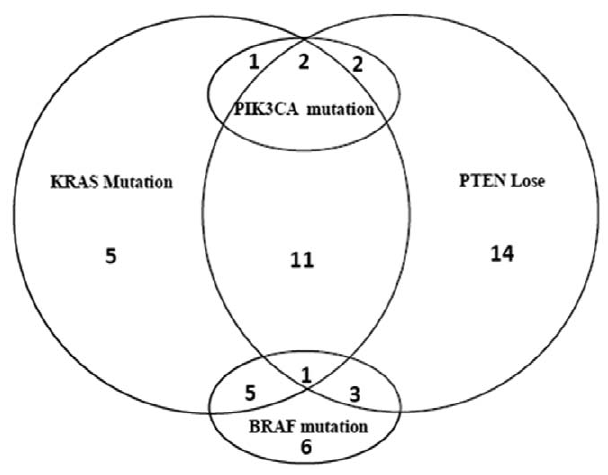
Figure 1. The interrelationship between four biomarkers.